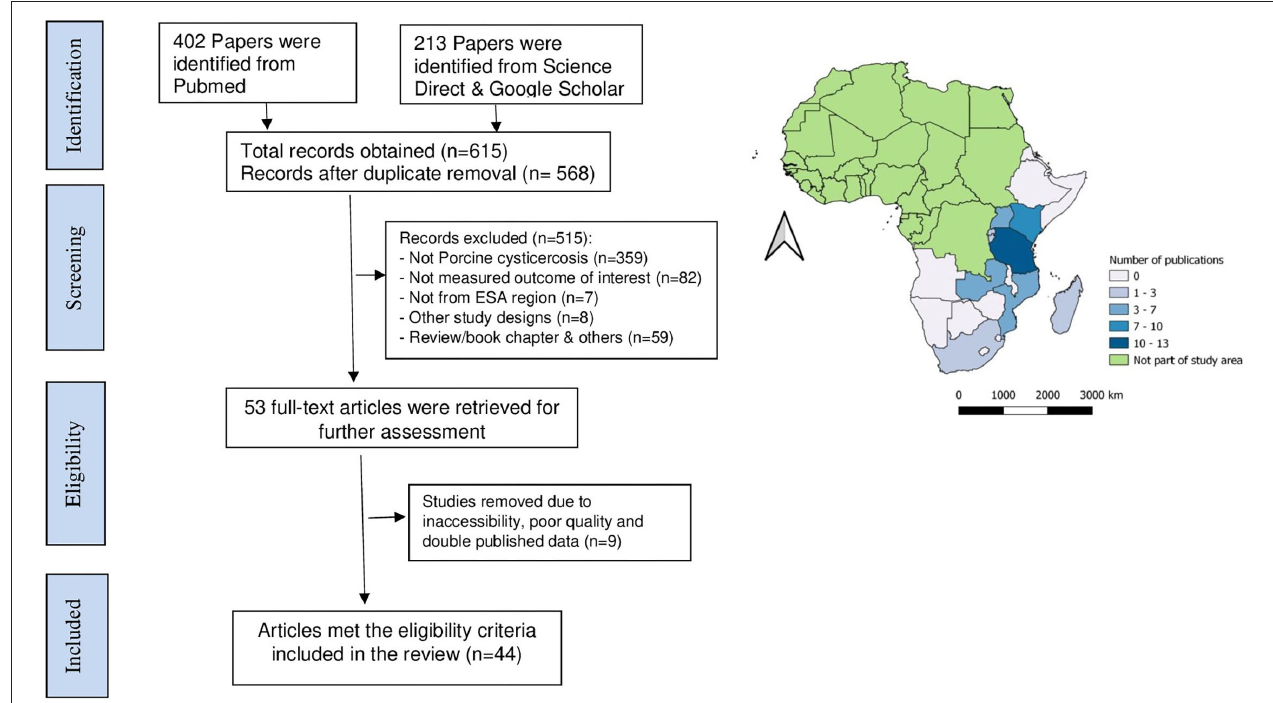
FIGURE 1 | The Preferred Reporting Items for Systematic Reviews and Meta-analyses (PRISMA) flow diagram (left ) and summary of publications available by country (right)